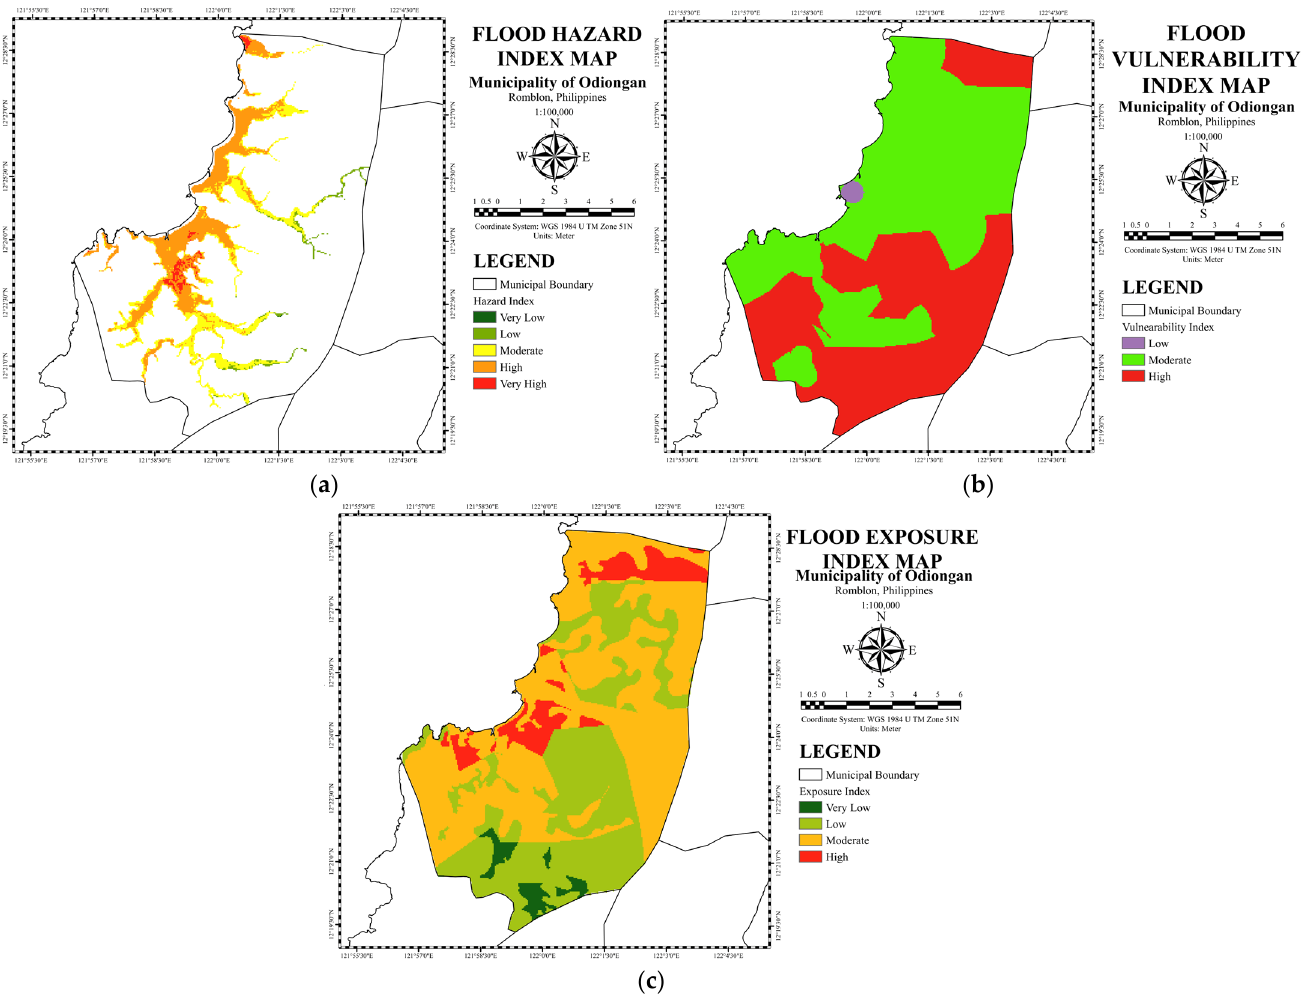
Figure 10. ( a ) Flood Hazard, ( b ) Flood Vulnerability, ( c ) Flood Exposure Index Maps of the Odiongan, Romblon, integrating all parameters in ArcGIS.